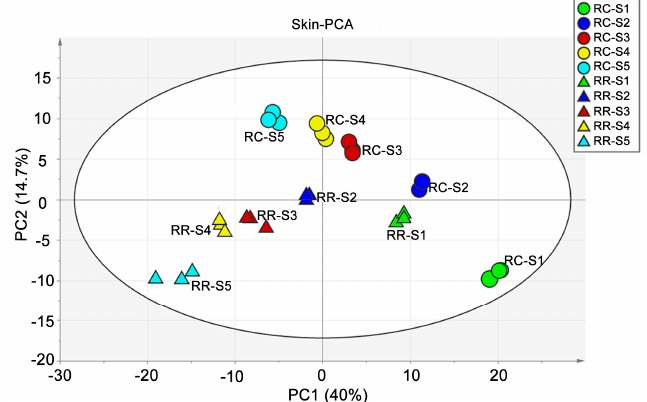
Figure 1. Principal component analysis (PCA) of the metabolites annotated in developing grape berry skin. Circle and triangle donate traditional cultivation (RC) and root restriction (RR) cultivation method, respectively. Green, blue, brown, yellow, and cyan colors represent samples collected at S1, S2, S3, S4, S5 stage, respectively. S1, eight weeks after full bloom (WAFB); S2, ten WAFB; S3, 12 WAFB; S4, 14 WAFB; S5, 16 WAFB (berry maturation). Principle Component (PC) 1 explains 40% of variance distinguishing grape berry skin samples from different developmental stages. PC2 explains 14.7% of variance distinguishing skin samples from different cultivation methods.